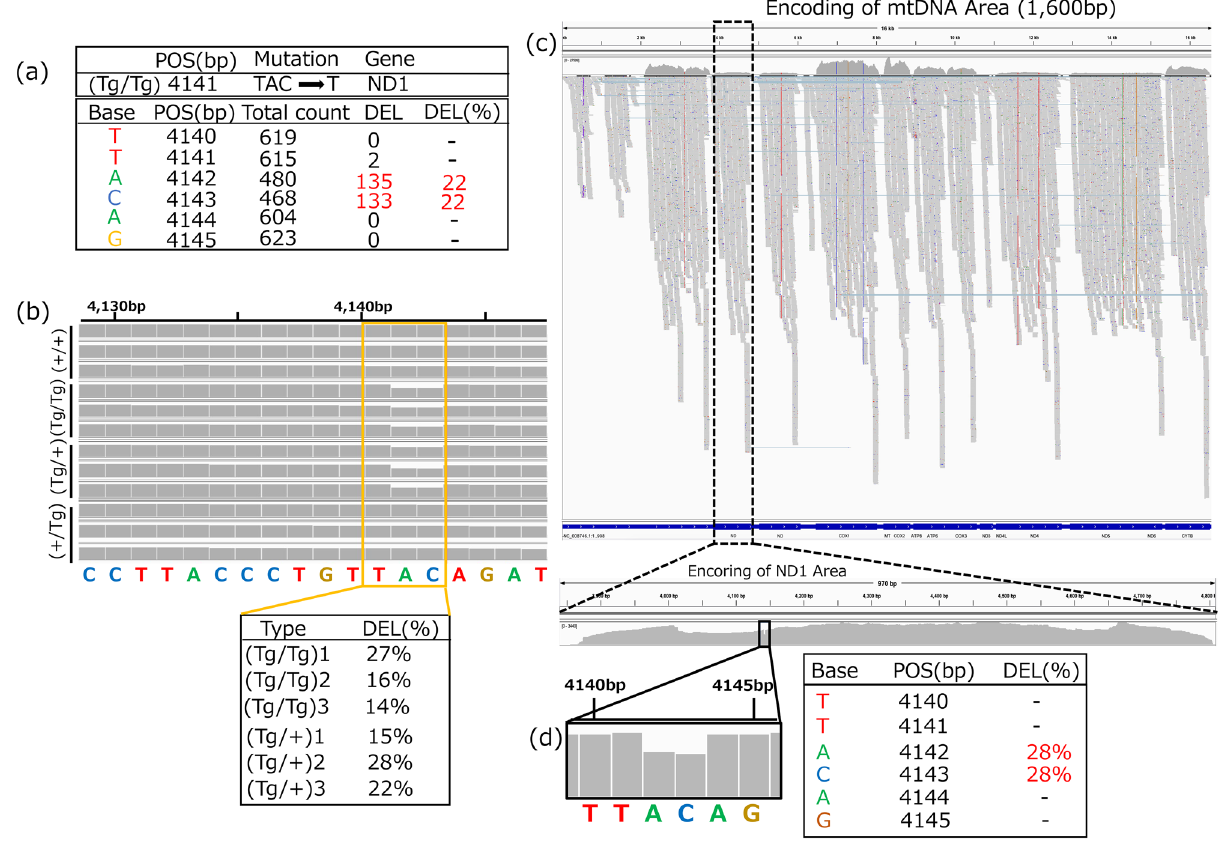
Figure 4. Analysis of mtDNA and mtRNA expression. ( a ) Mutation sites in mtDNA of (Tg/Tg) fish. “Total count” represents the total read count of no-deletion after eliminating duplication, and “DEL” denotes the read count containing the deletion mutation on the site. DEL % indicates that A and C were deleted at a rate of 22% [135/(480 + 135) × 100] and [133/(468 + 133) × 100] in the total mtDNA. ( b ) ND1 site variant analysis using mtDNA. Whole ND1 site sequencing was performed using three different fish. Type indicates fish, and DEL % denotes the average deletion mutation rate of A and C. ( c ) Validation of single nucleotide polymorphisms using RNA-seq. ( d ) The ratio of the deletion mutation in the ND1 mRNA of (Tg/Tg). Two fish from the (+/+) and (Tg/Tg) fish groups were used for whole mtDNA sequence, and three fish were used for the ND1 site sequence. One (Tg/Tg) fish was used for RNA seq for the ND1 site. ( c , d ) were created using Integrative Genomics Viewer (IGV: https:// softw are. broad insti tute. org/ softw are/ igv/ home) version